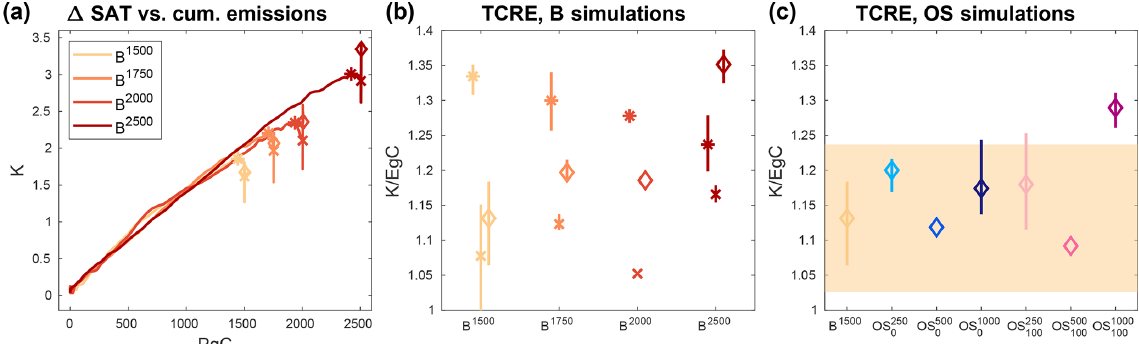
Figure 2. Relationship between global mean SAT increase and cumulative carbon emissions (a) , the value of TCRE at different points in time of the B simulations (b) , and TCRE at the end of the reference and the six overshoot simulations (c) . For the B simulations (a, b) the temperature maximum during the positive emission phases (stars), the temperature when emissions cease (x markers), and the temperature at the end of the simulations (diamonds) are indicated. In (b) and (c) , the vertical bars indicate the range of the three ensemble members and the marker symbol indicates the ensemble mean. The shaded area in panel (c) indicates the range of internal variability of the reference simulation B 1500 . In all panels an 11-year running mean of SAT has been